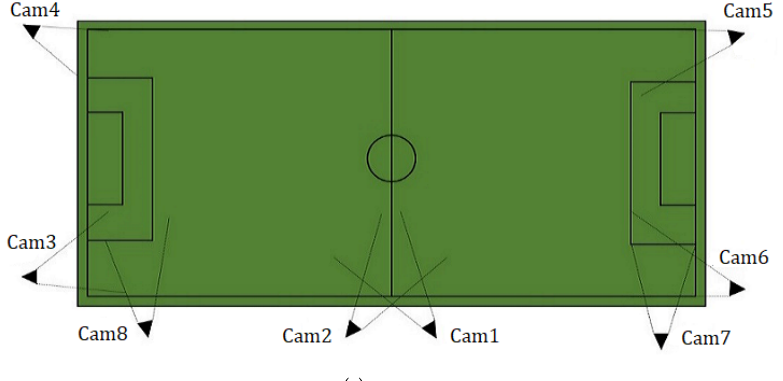
Figure 6. Camera placements in the playfield. ( a ) Ceiling-mounted camera [23]. ( b ) Birds eye view of the field [25,26]. ( c ) Multiple cameras placed to cover the complete playfield [27]. Morphological operations-based techniques can separate the playfield and non-playfield regions, but they cannot detect the lines in the playfield. The background subtraction-based current frame (i.e., by detecting moving objects in the frame); however, they fail to detect the playfield lines as shown in Figure 5. So, the best way to detect the playfield lines is by